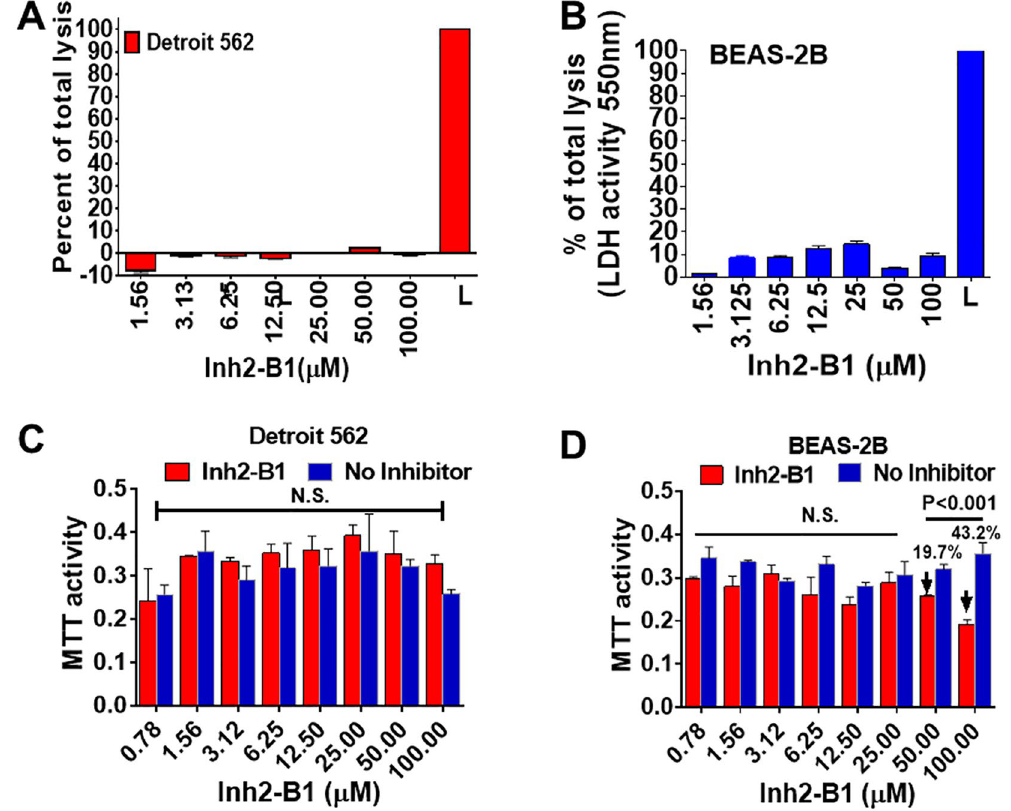
Figure 7. Human cell-dependent cytotoxic properties of Inh2-B1. ( A , B ) Lactate dehydrogenase (LDH) activity in Inh2-B1-treated human cell lines grown in 96-well tissue culture plates. LDH activity was measured in the supernatants of ( A ) Detroit 562, and ( B ) BEAS-2B cells lines treated with different concentrations of serially Inh2-B1 (serially 2-fold dilution- 100 µ M–1.56 µ M) for 24 h. LDH activity in individual wells was detected spectrophotometrically ( λ = 490 nm) and normalized to the LDH activity of the whole cell lysates of confluent cultures of different cell lines (L), which was treated as 100% lysis. ( C , D ) Effect of different concentrations (100 µ M- 0.78 µ M) of Inh2-B1 on the proliferation of ( C ) Detroit 562, and ( D ) BEAS-2B cell lines grown in 96 well tissue culture plates as determined by the MTT test. The cells were treated with Inh2-B1 in a final volume of 100 µ l for 24 h. At the end of incubation, tissue culture medium was removed and replaced with fresh 100 µ l of the medium containing MTT solution (0.5 mg/ml) and further incubated for 4 h. The purple color of formazan salt crystals formed in each well was solubilized and spectrophotometrically analyzed ( λ = 570 nm) as described in the Materials and Method section. Each bar shows the average (Mean ± S.D) reading of three different experiments each carried in triplicate wells. P < 0.05 treated as a significant difference. N.S. = not